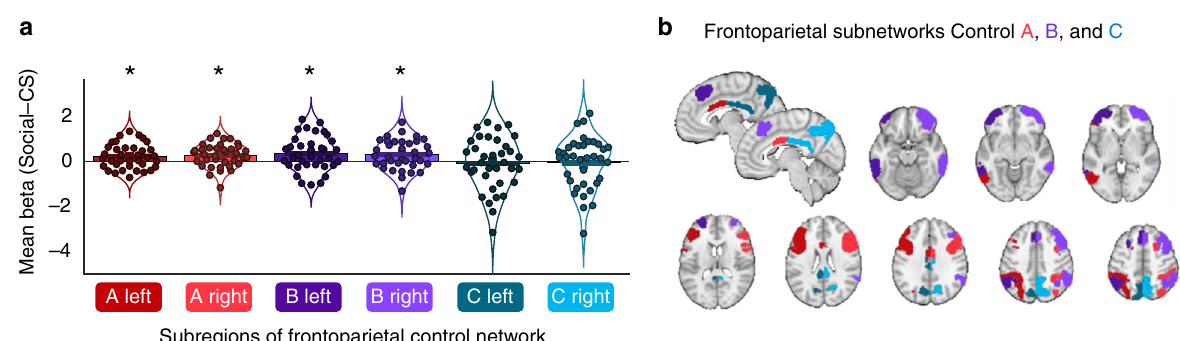
Fig. 4 Difference between Social and CS effects in frontoparietal control subnetworks. a Difference in mean path a beta weight (Social – CS) in Control A (dark and bright red), Control B (dark and bright purple), and Control C (dark and bright blue) subnetworks in the left and right hemisphere (dark and bright colors, respectively). Each dot re fl ects the difference in mean beta estimates of one participant. Signi fi cantly greater activation for social information was found in the Control A (left: t (35) = 2.3, p = 0.027, 95% CI = [0.03, 0.39], Cohen ’ s d = 0.38; right: t (35) = 2.9, p = 0.006, 95% CI = [0.08, 0.43], Cohen ’ s d = 0.48) and the Control B (left: t (35) = 2.6, p = 0.012, 95% CI = [0.08, 0.59], Cohen ’ s d = 0.44; right: t (35) = 2.6, p = 0.013, 95% CI = [0.07, 0.51], Cohen ’ s d = 0.44), but not in the Control C network. Asterisks denote networks with signi fi cant differences between social information and CS effects (using t-tests, p < 0.05). Source data are provided as a Source Data fi le. b Display of frontoparietal control subnetworks A (dark and bright red), B (dark and bright purple), and C (dark and bright blue) on sagittal and transversal brain